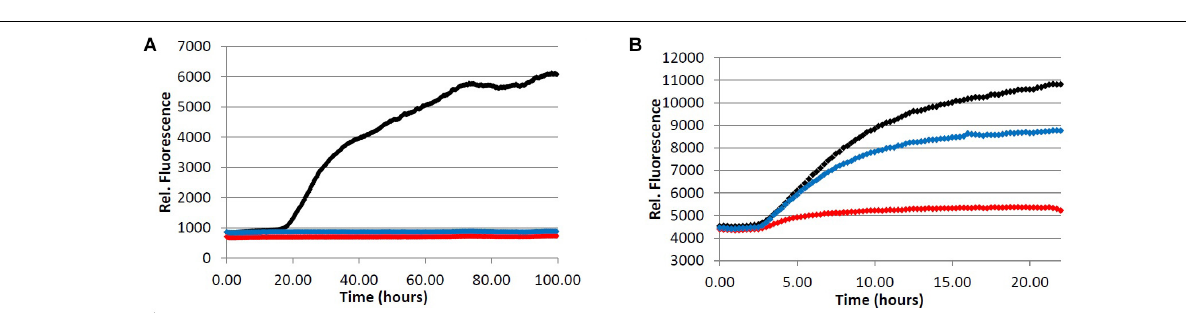
FIGURE 5 | Inhibition of fibril formation by phenylindane 6 . (A) Fibrillization of A β peptide. 20.0 µ M A β 1 − 40 in Tris buffer (20.0 mM, pH 7.4, 150 mM NaCl) was incubated at 37.0 ◦ C in the presence of 4.0 µ M ThT and variable concentration of analyte. (B) Fibrillization of tau protein. 4.0 µ M tau in Tris buffer (50.0 mM, pH 7.4, 10.0 µ g/mL heparin, 1.0 mM dithiothreitol, 50.0 mM sodium azide) was incubated at 37.0 ◦ C in the presence of 5.0 µ M ThS and variable concentration of analyte. (red) = 100 µ M, (blue) = 20.0 µ M, (black) = 0.0 µ M (vehicle control).